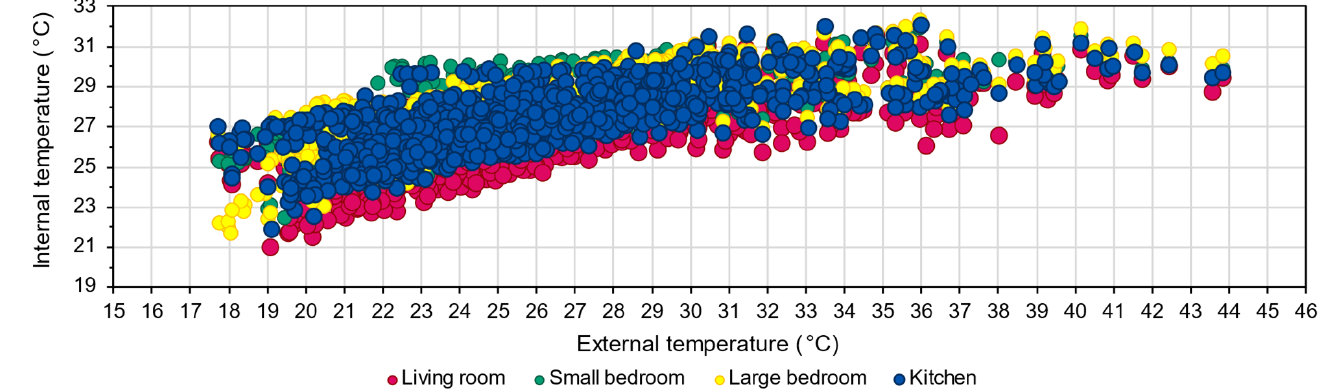
Figure 12. Internal room temperatures as the function of the external temperature within the meas- urement period.